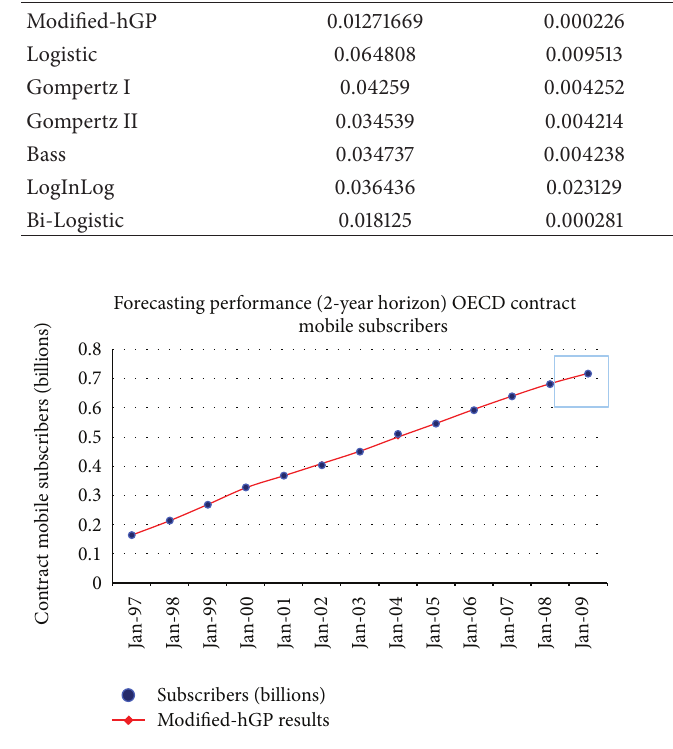
Figure 22: The forecasting performance of the modified-hGP (forecast window—2 years ahead) for the number of OECD mobile contract subscribers.